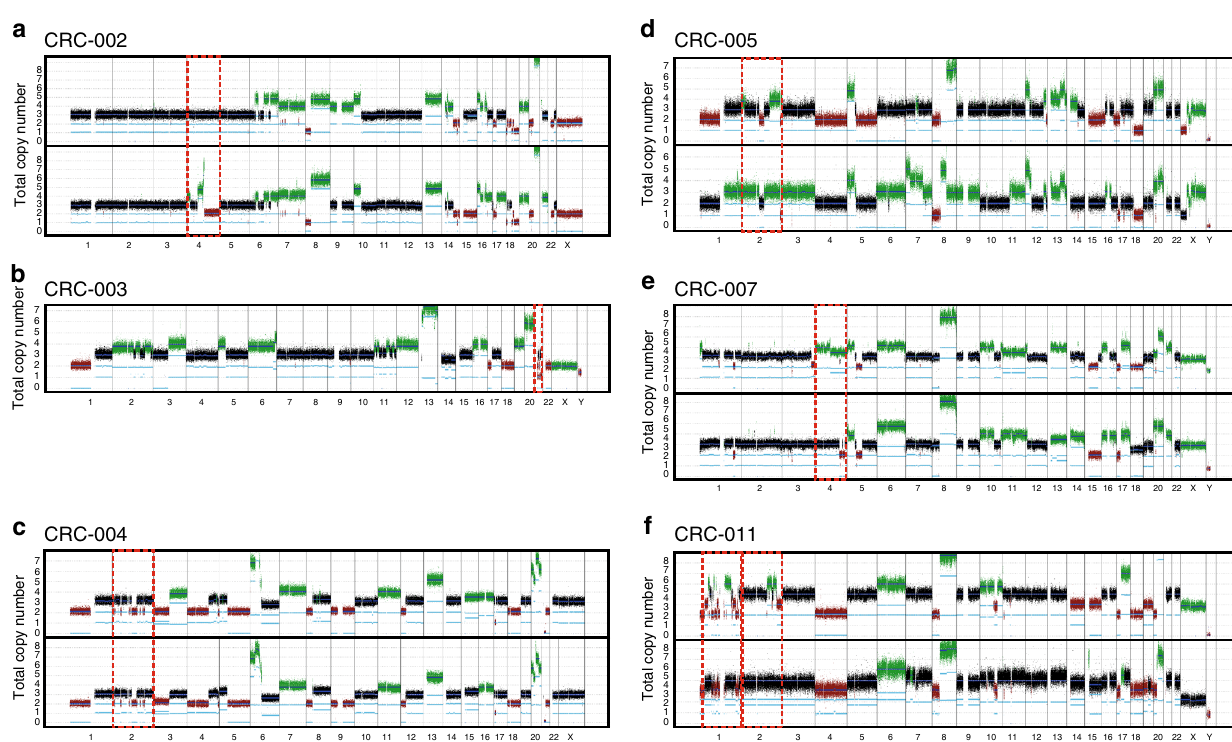
Fig. 3 Chromothripsis and negative selection of highly rearranged chromosomes. Chromosome copy number predictions of six samples a – f , showing predicted copy number of tumor (top) and metastasis (bottom) samples. Regions of chromothripsis-like rearrangements b , c , f and highly rearranged events not present in the metastasis a , d , e , f are highlighted in dashed red